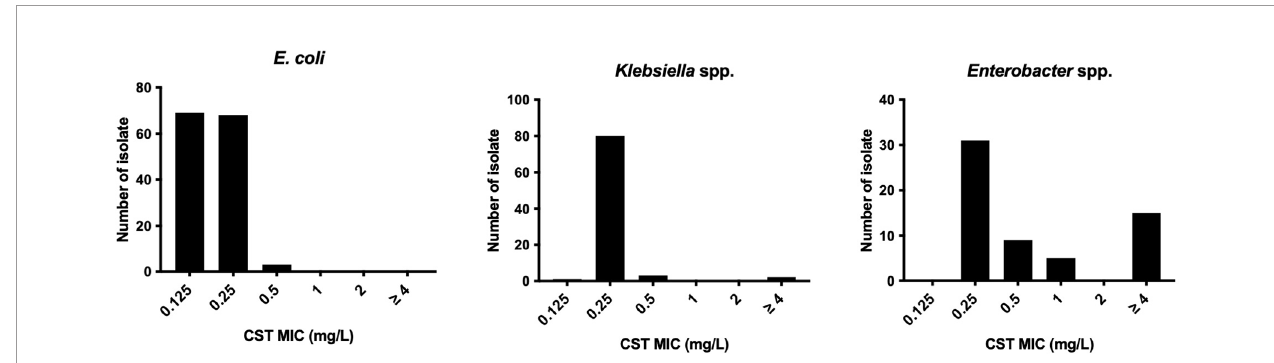
FIGURE 1 | Colistin susceptibility in E. coli , Klebsiella spp., and Enterobacter spp. clinical isolates derived from companion